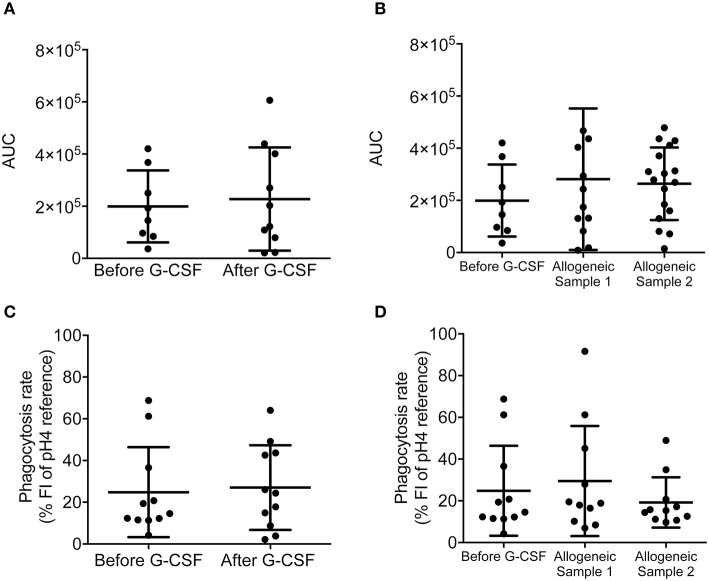
ROS production and phagocytosis are not affected by G-CSF in stem cell donors and neither in allogeneic transplant recipients. (A) Production of ROS by neutrophils was measured as area under the curve (AUC) in the stem cell donor group before and after G-CSF-treatment (n = 10). Statistical analysis was performed using an unpaired students t-test. (B) Production of ROS measured as AUC in the samples from patients undergoing allogeneic stem cell transplantation using the samples from the stem cell donors before G-CSF-treatment as a control. Statistical analysis was performed using a Kruskal-Wallis test due to skewness of data. (C,D) Phagocytosis measured as the uptake of pH-sensitive pHrodo beads that triggered phagocytosis by neutrophil isolated from (C) stem cell donor group before and after G-CSF-treatment (n = 10) and from (D) patients undergoing allogeneic stem cell transplantation using the samples from the stem cell donors before G-CSF-treatment as a control. Phagocytosis rate was calculated as percent out of 100 percent control. Statistical analysis was performed using a One-way ANOVA with Tukey's multiple comparison tests. Statistical analyses in (A-D) did not reveal significance p < 0.05.